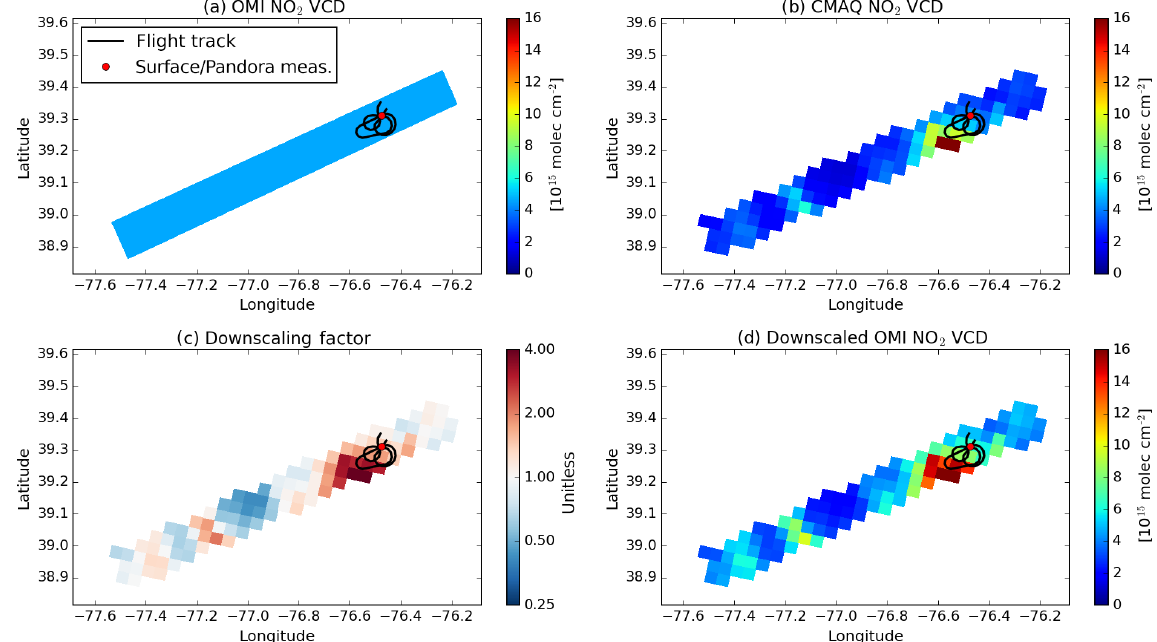
Figure 4. An illustration of downscaled OMI NO 2 for an OMI pixel over Essex, MD, from orbit 37024 on 1 July 2011. Shown are the original OMI tropospheric NO 2 VCD (a) , coincidently sampled CMAQ NO 2 VCD at a spatial resolution of 4 × 4km 2 (b) , the spatial- weighting kernel (c) , and downscaled OMI tropospheric NO 2 VCD (d) . These pixels coincide with an airborne in situ NO 2 profile sampled during the DISCOVER-AQ Maryland campaign, and the flight route is marked with a black line. The location of the NO 2 surface monitor and Pandora instrument is marked with a red